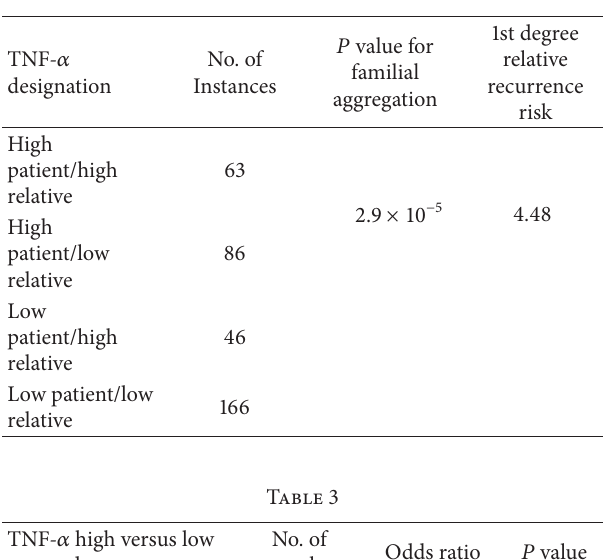
Figure 2: Serum TNF- 𝛼 levels in first degree relatives of SLE patients, spouses of SLE patients, and unrelated controls. Bars show the median; error bars show the interquartile range, 𝑃 values by Mann-Whitney 𝑈